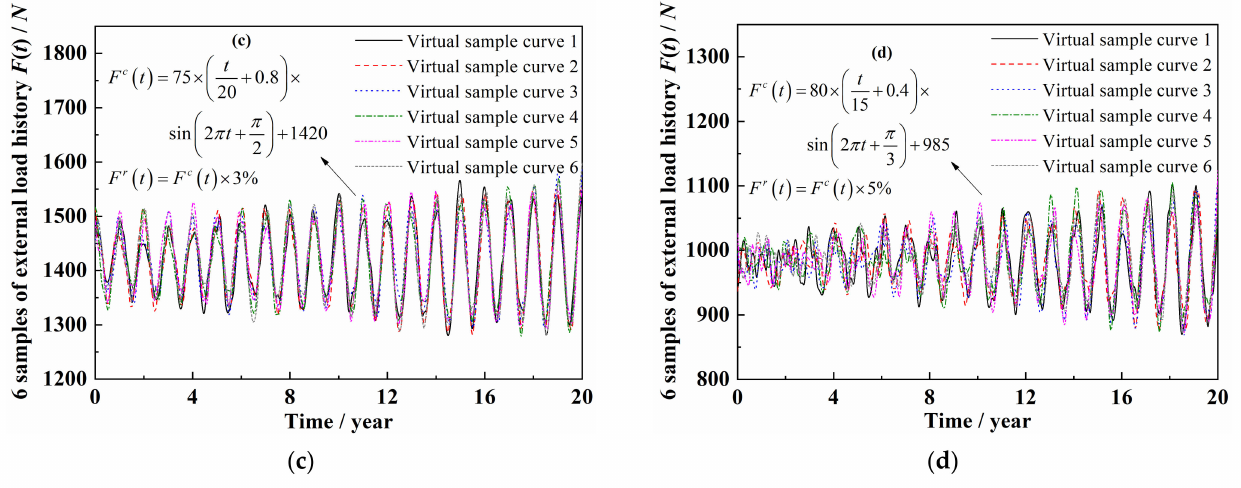
Figure 4. Six groups of virtual simulation histories subjected to external excitation F ( t ) (Case ( a – d )). In accordance with Equations (10) and (11), the experimental data points of E 1 can be listed